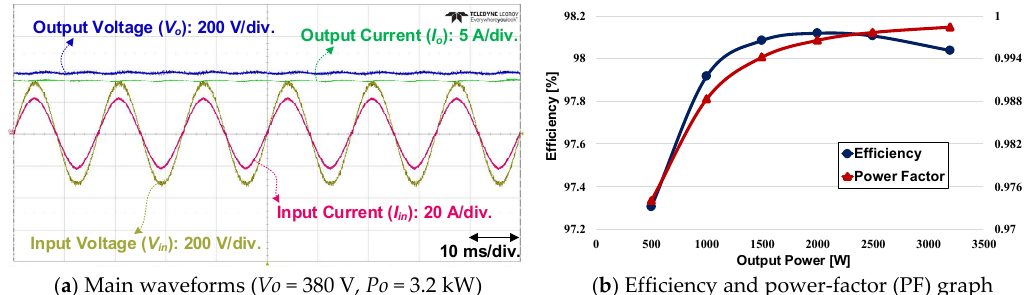
Figure 16. Waveforms of power-factor correction (PFC) circuit.